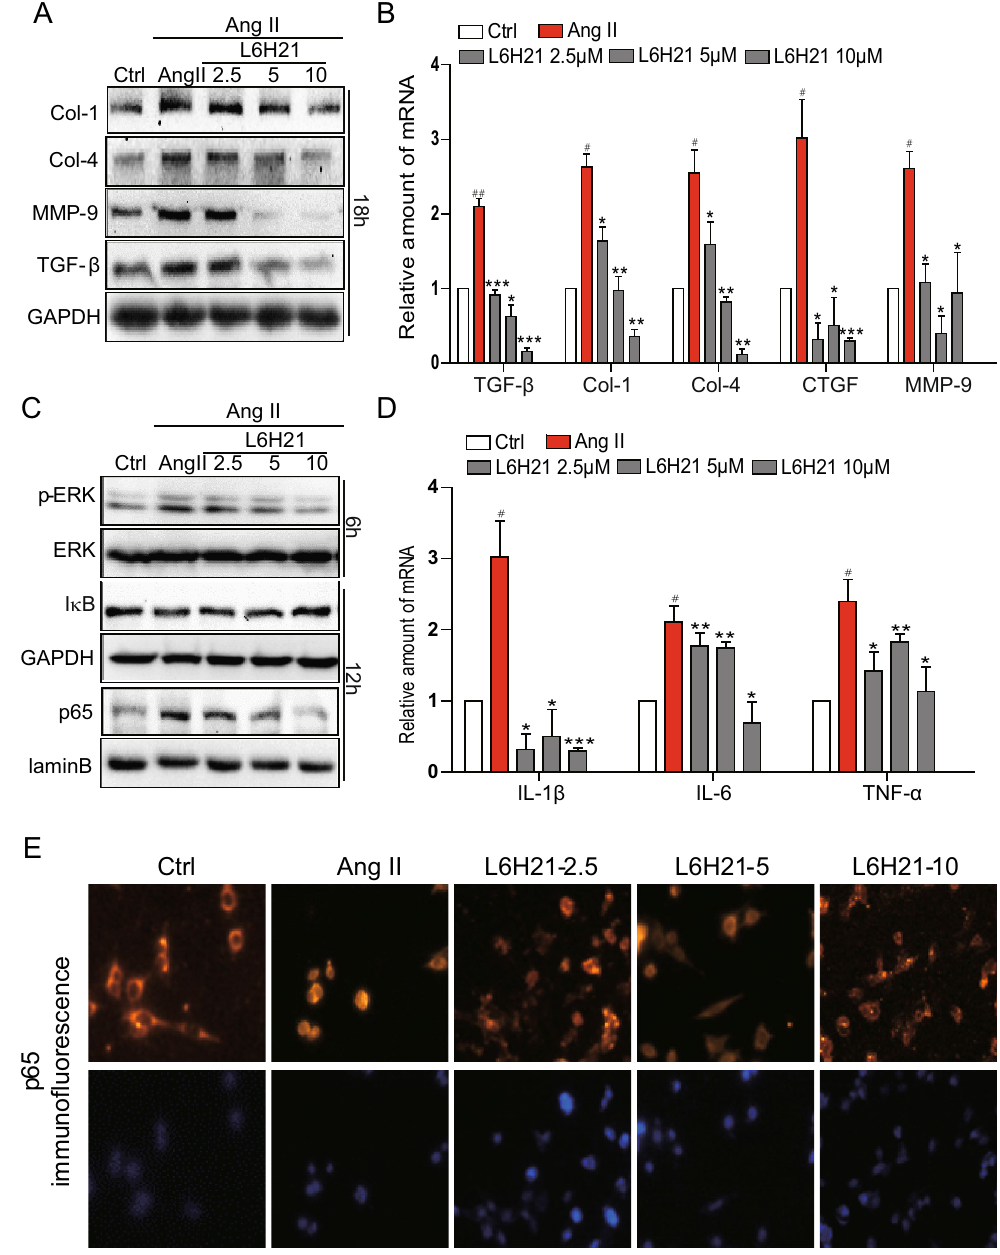
Figure 3. L6H21 pretreatment prevents Ang II-induced fibrosis and signal activation in renal tubular epithelial cells. The effects of the MD2 inhibitor L6H21 on Ang II-stimulated inflammatory responses in the renal tubular epithelial cell line, NRK-52E, were determined. NRK-52E were pretreated with the vehicle control DMSO (Ctrl) or L6H21 (2.5, 5.0, 10 μM) for 1 h, and stimulated with Ang II (1 μM) for different periods. ( A ) Representative Western blot analysis for protein markers of fibrosis, Col-1 (collagen 1), Col-4 (collagen 4), MMP-9 (metalloproteinase 9), and TGF-β (transforming growth factor β), GAPDH as loading control; n = 3 independent determinations. ( B ) The mRNA levels of TGF-β, Col-1 (collagen 1), Col-4, CTGF, and MMP-9 were detected by real-time qPCR; values normalized to house-keeping gene β-actin. ( C ) Representative Western blot analysis for p-ERK (phosphorylated ERK) and IκB from total cell lysate, GAPDH as loading addingol, ERK = total ERK; NF-κB p65 subunit detected from nuclear cell fraction, lamin B as loading control; n = 3 independent determinations. ( D ) The mRNA levels of IL-1β, IL-6 and TNF-α were detected by real-time qPCR; values normalized to house-keeping gene β-actin. ( E ) Representative immunofluorescent distribution of NF-κB p65 subunit (Texas-red streptavidin), top row; same cells counterstained with nuclear stain DAPI, bottom row, 200× magnification; n = 3 independent determinations. Data in B and D are reported as mean ± S.E.M. of n = 3, *P < 0.05, **P < 0.01, ***P < 0.001 versus Ang II-treated group; # P < 0.05 and ## P < 0.01 versus Ctrl. For panels ( A , C ) the gels were run under the same experimental conditions. Shown are cropped gels/blots (The gels/blots with indicated cropping lines are shown in Supplementary Figure